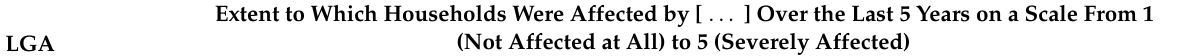
Table 3. Respondents’ perceptions on the effects of shocks experienced over the last 5 years.